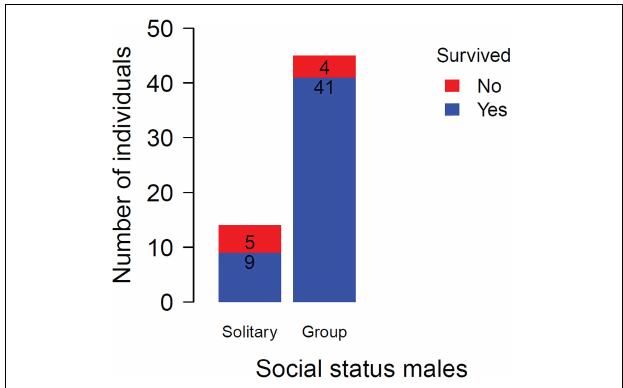
FIGURE 4 | Survival rates of males associated with a group versus those living solitarily over 37 days (from beginning to end of the respective field season). Numbers indicate sample